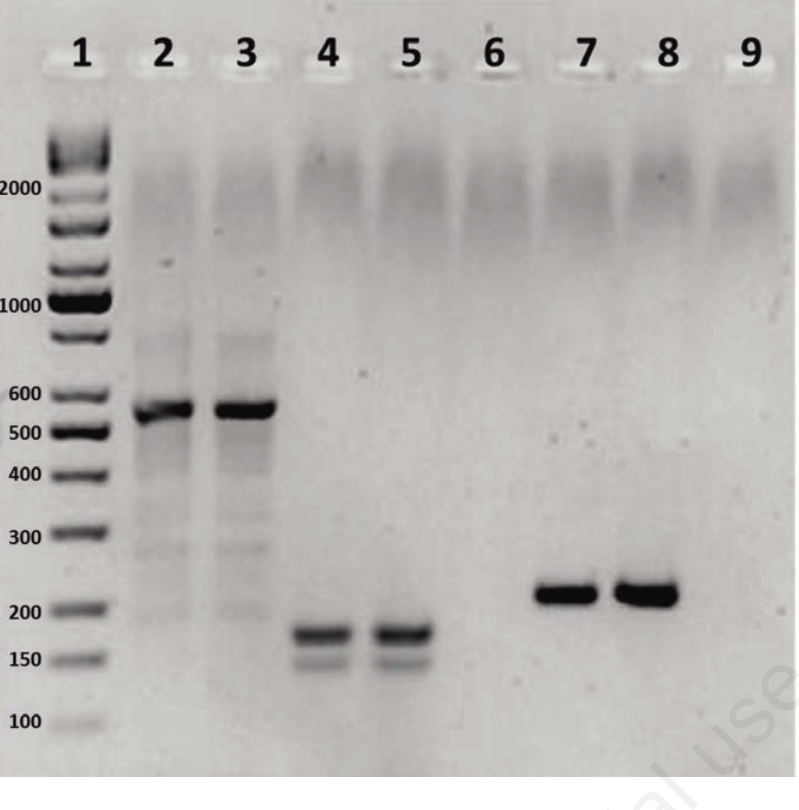
Figure 3. Case 1, molecular identification of filarial worm; 1.5% agarose gel. Lane 1: DNA fragment size markers (bp); Lanes 2 and 3: panfilarial sequence (ribosomal inter- genic and ITS2 regions); Lanes 4 and 5: D. repens small ribosomal subunit intergenic region, showing 2 bands; Lanes 7 and 8: D. repens cytochrome oxidase subunit I sequence; Lanes 6 and 9: negative PCR